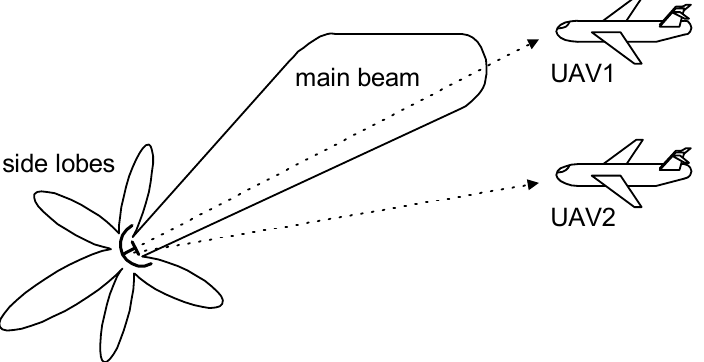
Figure 1. Side-view of the directional pattern for an example radar antenna system.